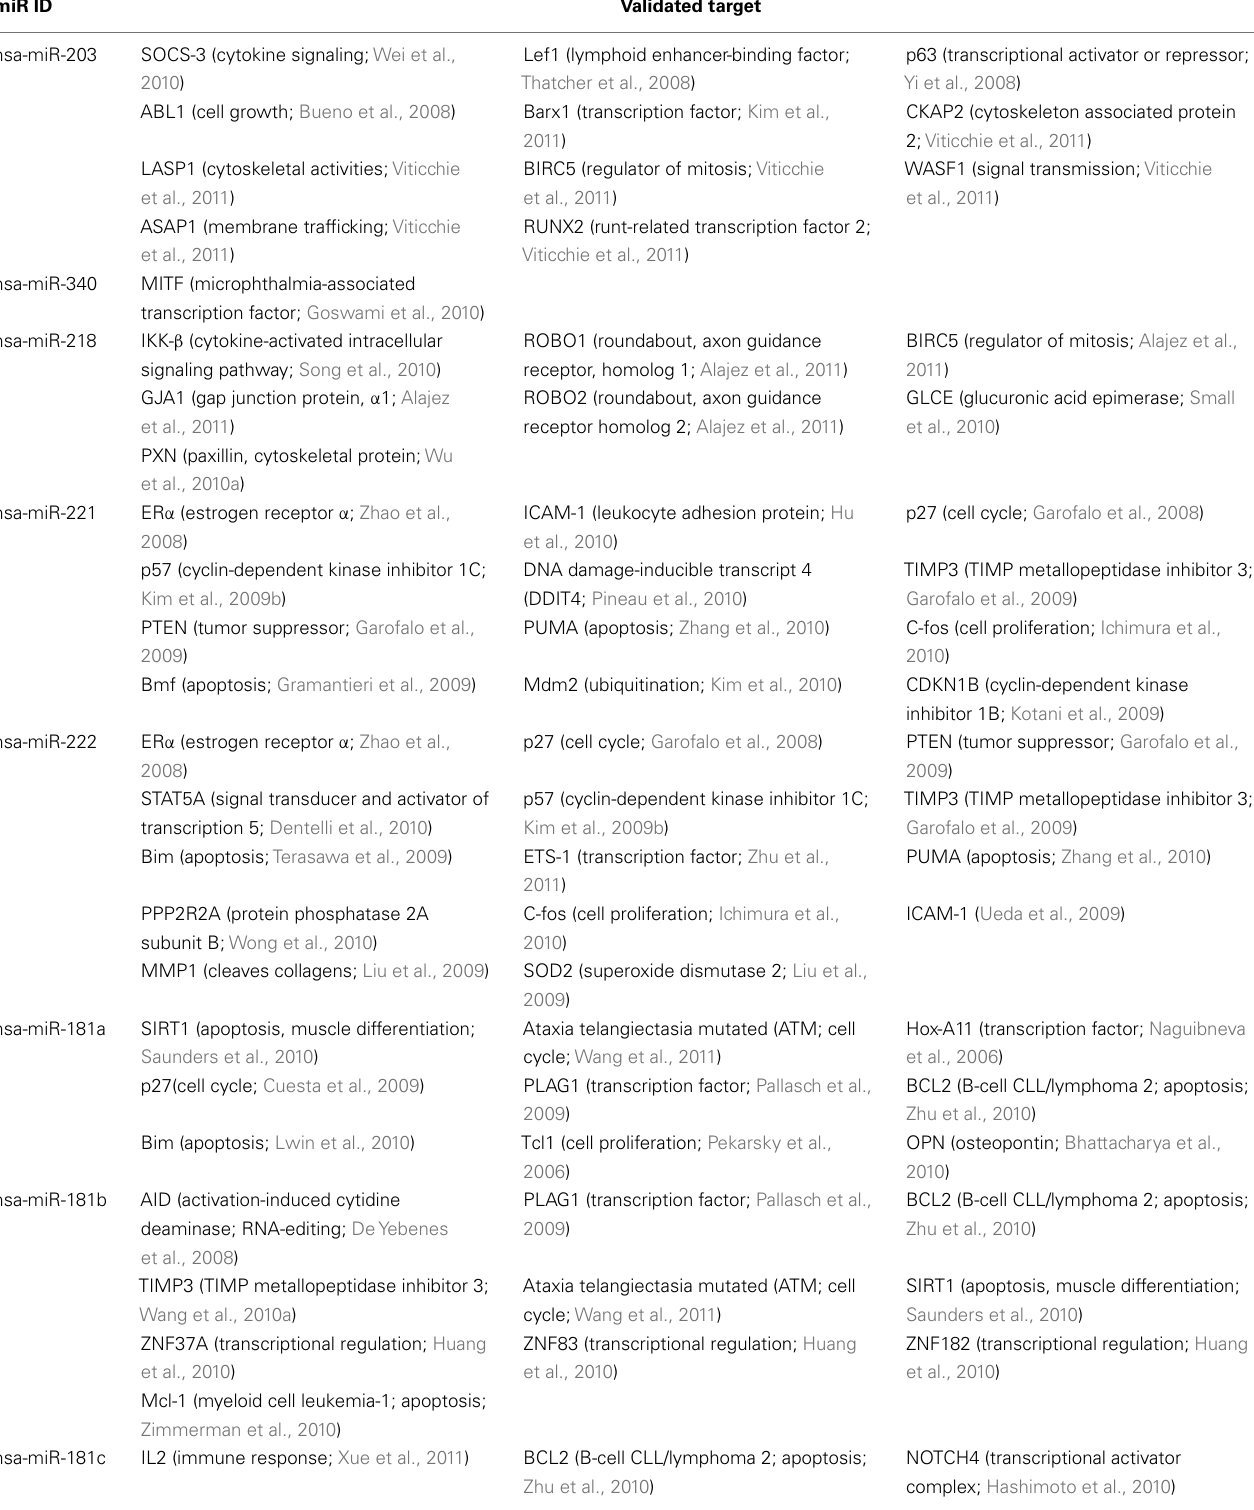
TableA3 |Additional targets of BChE-targeting microRNAs. miR